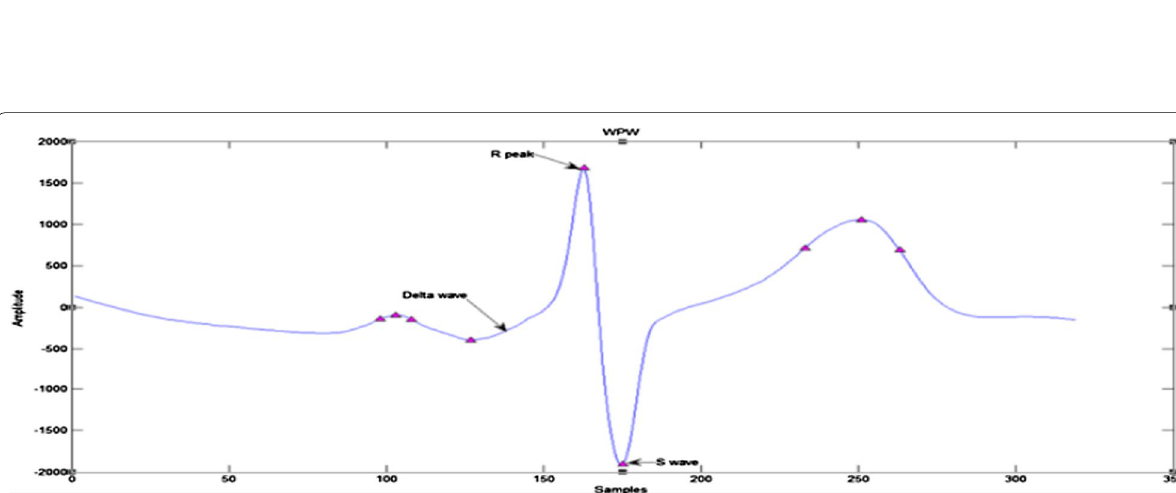
Fig. 14 Averaged signal of WPW of record 230 and detected fiducials: The figure shows the folded signal of WPW arrhythmia based on the period-dependent gate which gives the averaged information about the